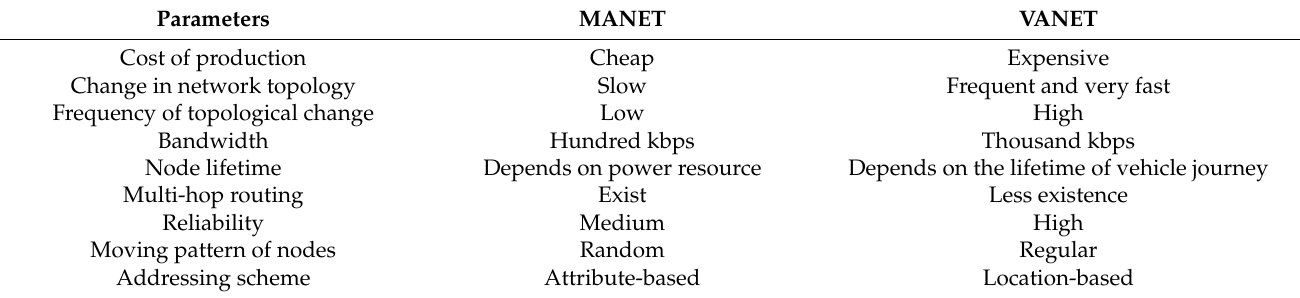
Table 1. MANET and VANET